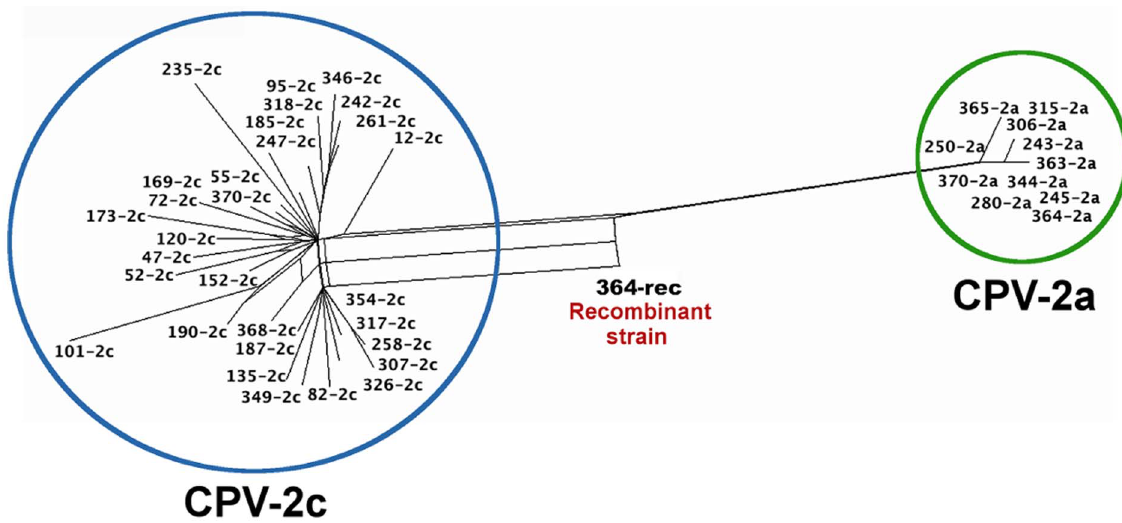
Figure 1. CPV recombination network. The phylogenetic network was generated from alignment of 42 complete CPV genome sequences. There are two main clades encompassing CPV-2c and CPV-2a strains (circles), and an edge (split) that reveals a possible recombination event involving strain 364-rec (KM457139). The Phi test for recombination was significant at p=0.003.